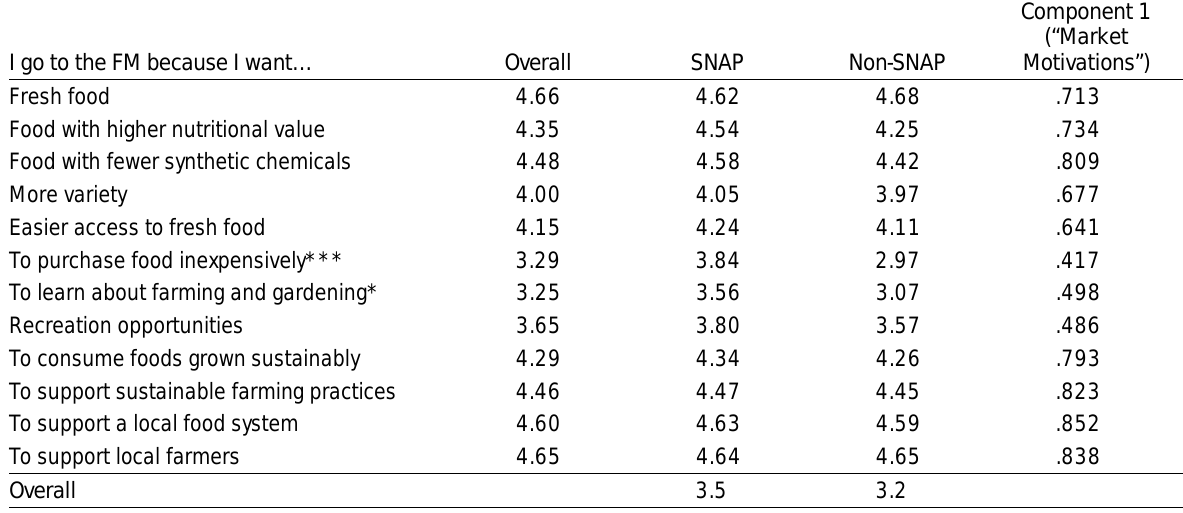
Table 2. Agreement with Common Motivations for Attending a Farmers Market: Overall and Group Mean Scores as Well as PCA Results from Q9 of the Survey (1=strongly disagree to 5=strongly